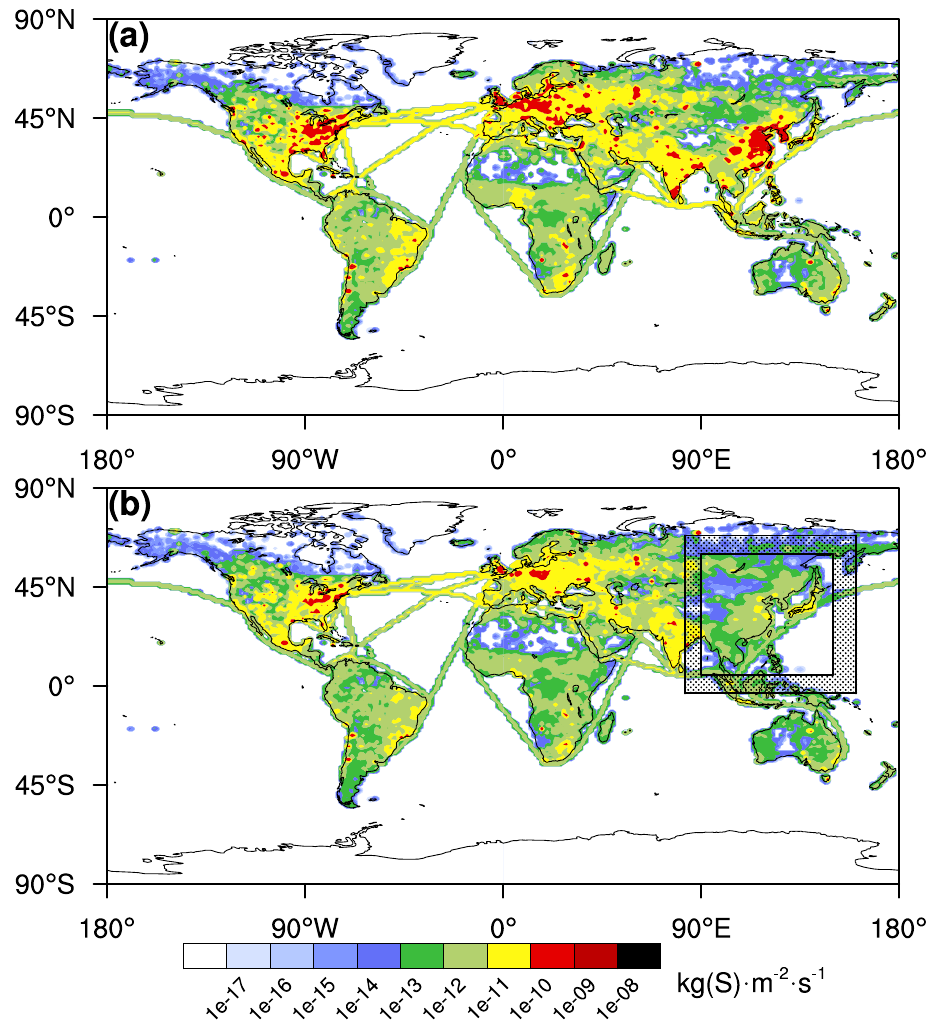
Fig. 1. Annual mean SO 2 emissions. Units: kg(S)m − 2 s − 1 . (a) Emissions in 2000. (b) Same as (a) , except that, within the inner box (5– 60 ◦ N, 90–150 ◦ E), the emissions are in the level of 1950. A linear transition is applied between inner and outer boxes. Emission data is from Smith et al. (2004).